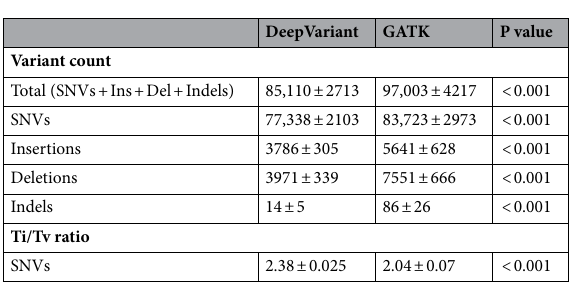
Table 1. Comparison of variant counts from the two pipelines (n = 77 trios).